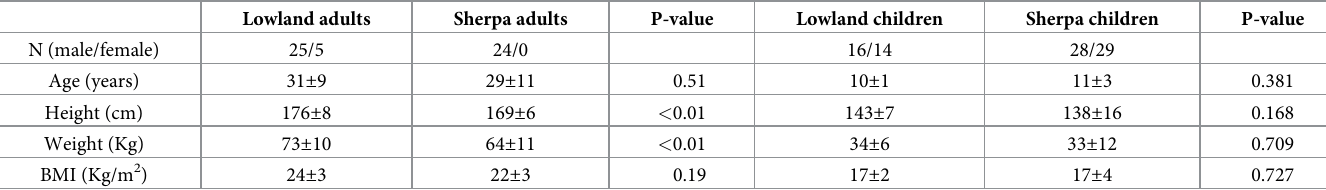
Table 2. Participant demographics and